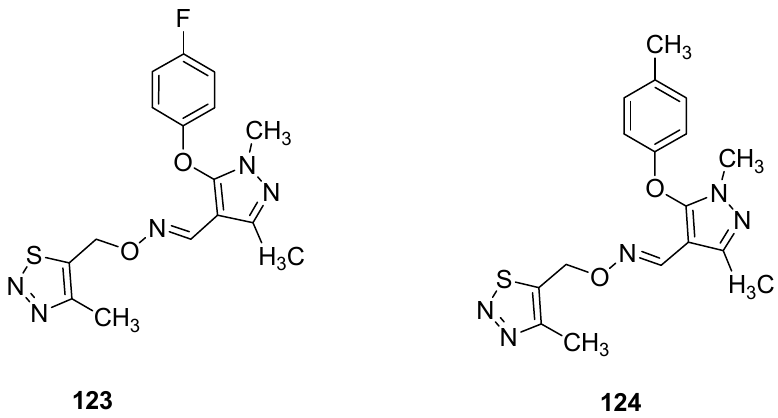
Figure 20. Ethers of pyrazole oximes 123 and 124 with insecticidal properties.